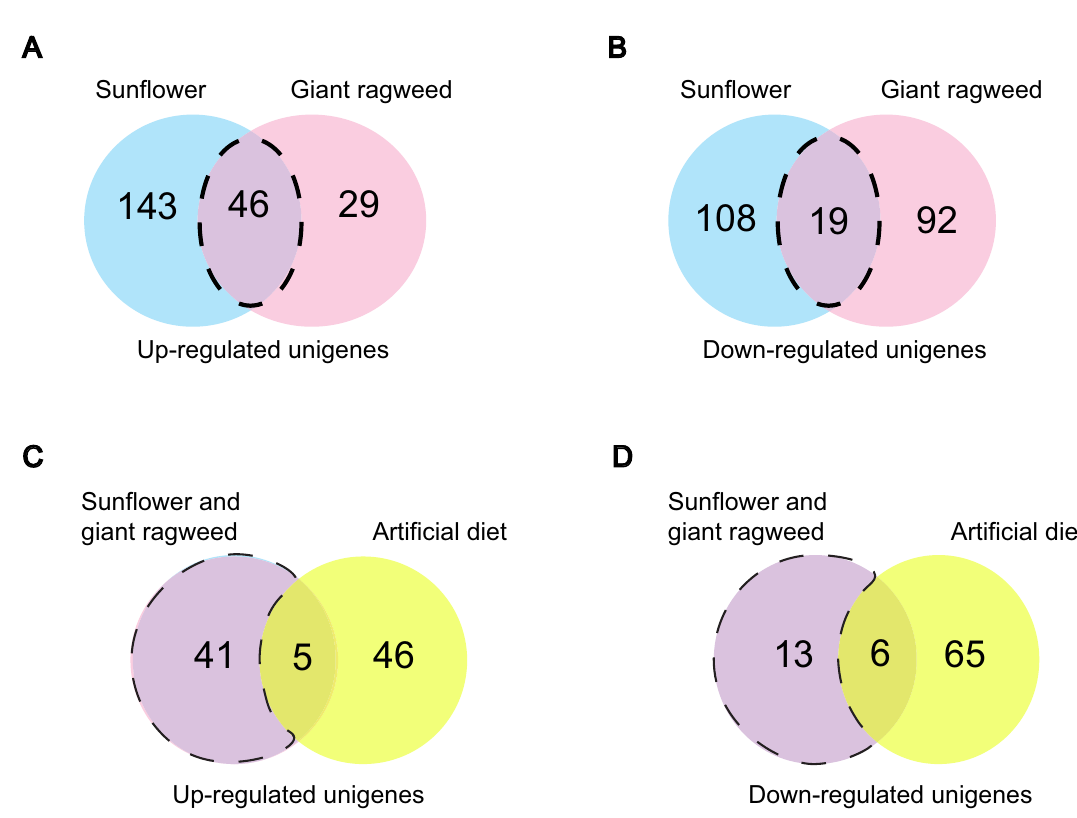
Figure 1. Number of differentially expressed unigenes in Dectes texanus larvae fed soybean compared to those fed other diet treatments (Fold change > ± 1.5, False Discovery Rate < 0.05). ( A ) up-regulated and ( B ) down-regulated unigenes compared to larvae fed sunflower or giant ragweed; ( C ) up-regulated and ( D ) down- regulated unigenes compared to larvae fed both primary hosts or artificial